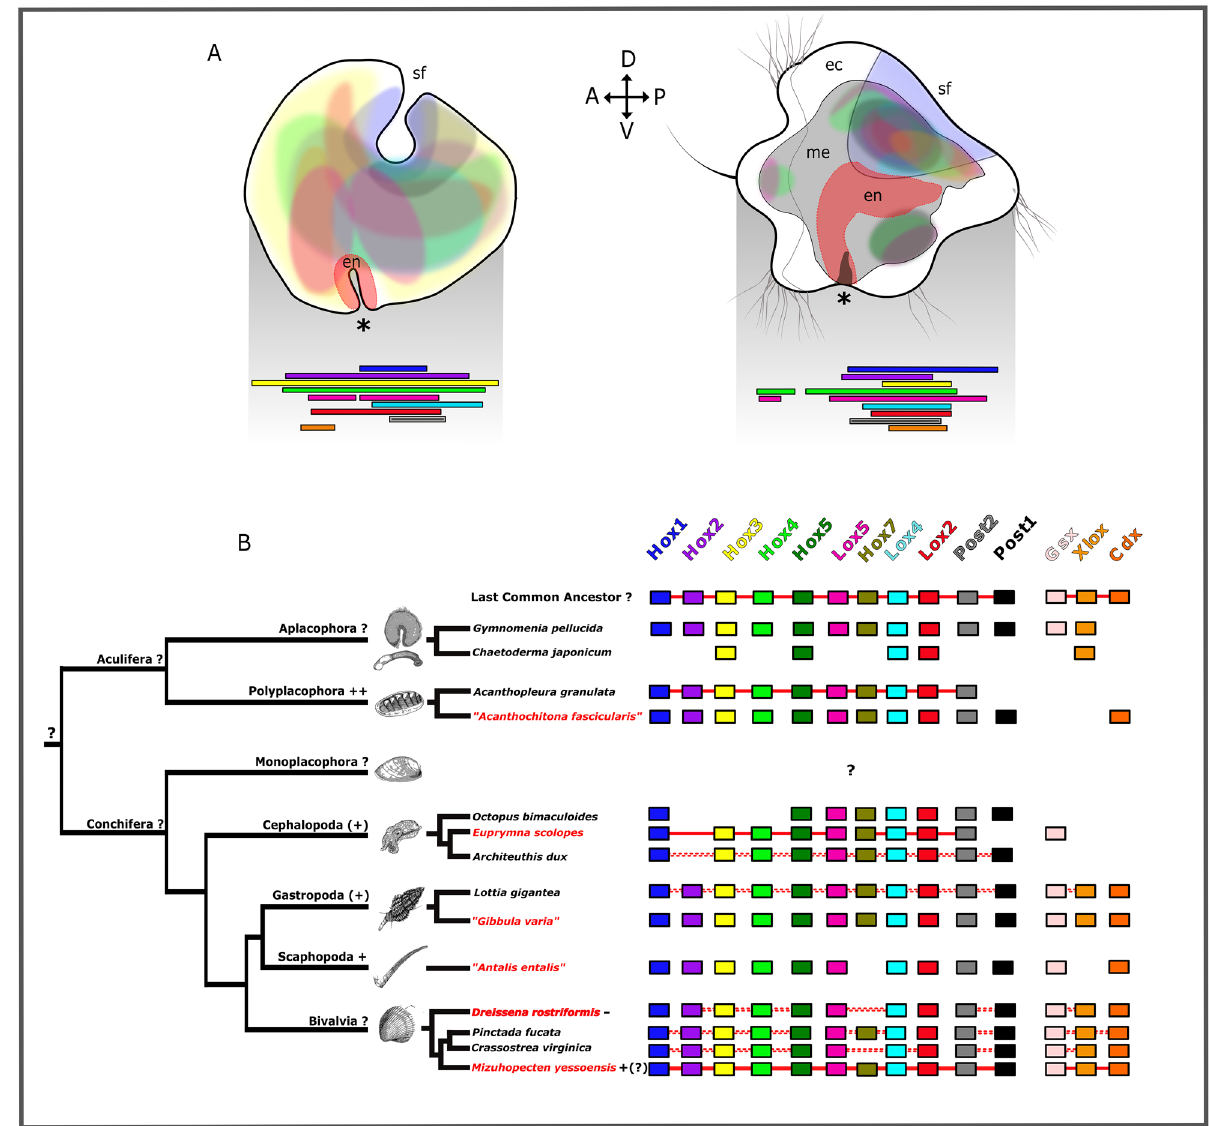
Figure 4. Schematic representation of Hox gene expression in Dreissena rostriformis . Summary of Hox expression patterns together with the localization of Hox genes in the genome of selected mollusk species. ( A ) Hox genes in the late gastrula (left) and the late trochophore larva (right) do not follow a temporally or spatially staggered mode of expression. ( B ) Hox gene arrangement in mollusks. Phylogenetic tree adapted from 1,66 , animal schemes modified after 67 . Data from 16,18,19,35,39,57,68 . Straight red lines indicate absence of coding sequences between individual Hox genes, dotted red lines indicate presence of non-Hox genes between Hox genes, blank space between Hox genes means that presence or absence of non-Hox genes between Hox genes remains unknown. Species for which gene expression data by in situ hybridization are available are highlighted in red. ++ marks lineages with clear spatially staggered Hox expression, + indicates prominent hints of spatial Hox expression, ( +) symbolizes weak hints of spatial expression, - indicates absence of staggered expression, ? indicates that no clear statement concerning staggered Hox expression can be made. Note that the situation in Mizuhopecten yessoensis is somewhat undecided since only few Hox genes were investigated in the gastrula stage only. Quotation marks indicate that species identity is not fully settled ( G. varia , A. entalis ) or that genomic and gene expression data for the identical species have been published under different species names ( A. fascicularis , where gene expression data were erroneously assigned to A. crinita ). a, anterior; d, dorsal; ec, ectoderm; en, endoderm; me, mesoderm; p, posterior; sf, shell field; v, ventral; asterisk, blastopore/mouth